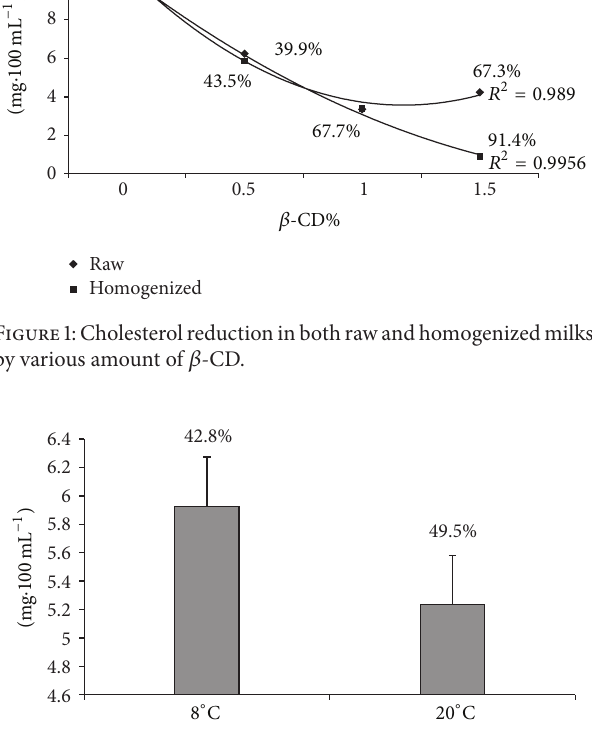
Figure 2: The cholesterol reduction in milk for both mixing temperature